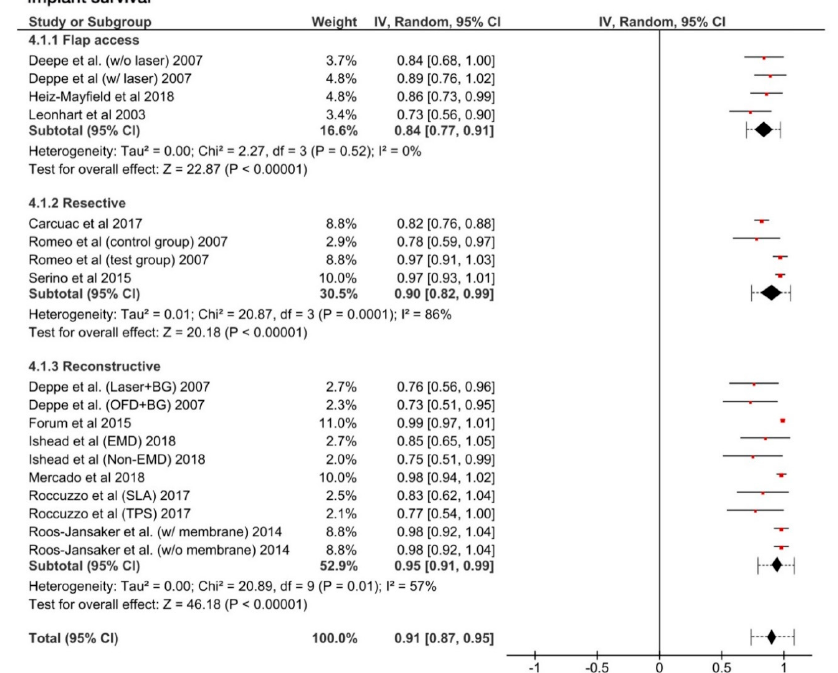
Figure 5. Implant survival rate after treatment of peri-implantitis following flap access, resective or reconstructive approaches. Mean implant survival rate of each study is reported by a red dot. The calculated 95% confidence intervals are indicated with horizontal lines intersecting the mean probing depth reduction. The estimate average and confidence interval of all the individual studies are reported with black diamonds. Prediction intervals are reported as dotted lines intersecting the diamonds. Abbreviations. BG: bone grafting, CM: collagen membrane, EMD: enamel matrix